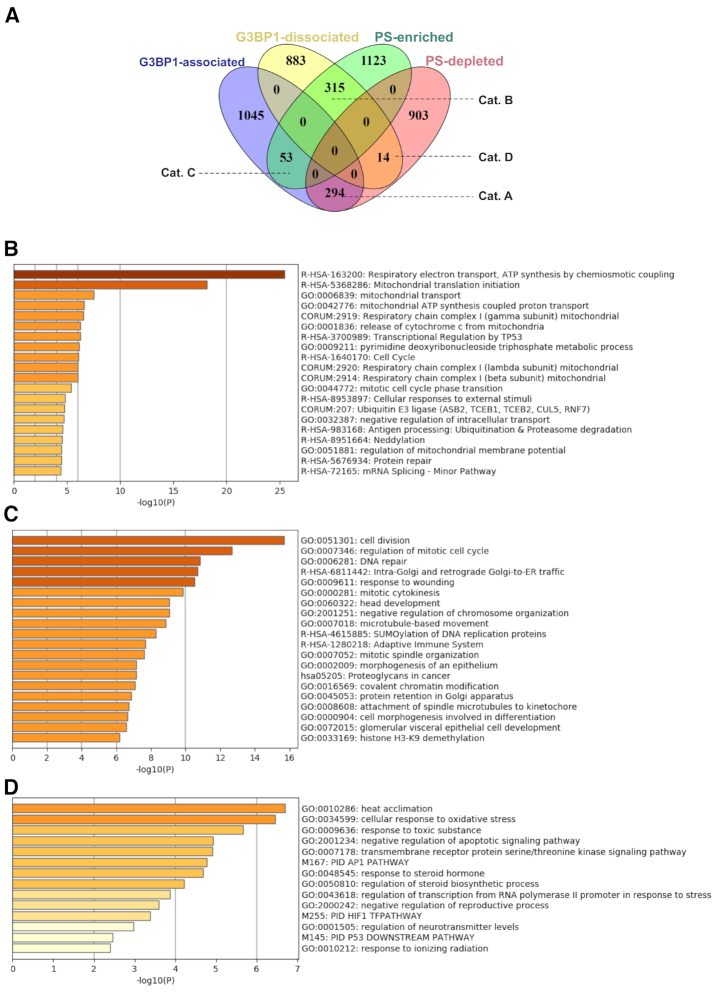
Compartmentalization of G3BP1-associated transcripts with PSs and their gene ontology analysis. (A) Venn diagram illustrating the compartmentalization of G3BP1-associated and dissociated/reduced transcripts within (PS-enriched) or away (PS-depleted) from PSs in stressed PC-3 cells revealed four categories; Cat. A-D. Gene ontology analysis of G3BP1 partitioned transcripts, (B) corresponding to Cat. A, (C) corresponding to Cat. B and (D) corresponding to Cat. C, using Metascape software.